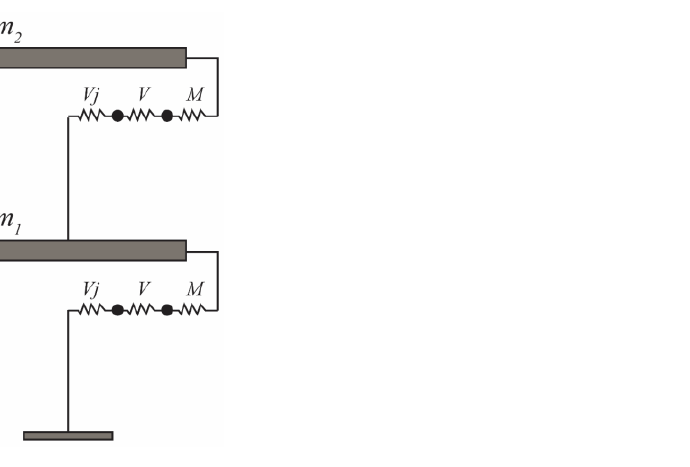
Figure 1. Mechanical idealization of an example two-story one-bay 2D frame with column-driven failure, where in each column three resisting mechanisms are considered: bending ( M ), shear ( V ), and joint shear ( 𝑉 𝑗 ).